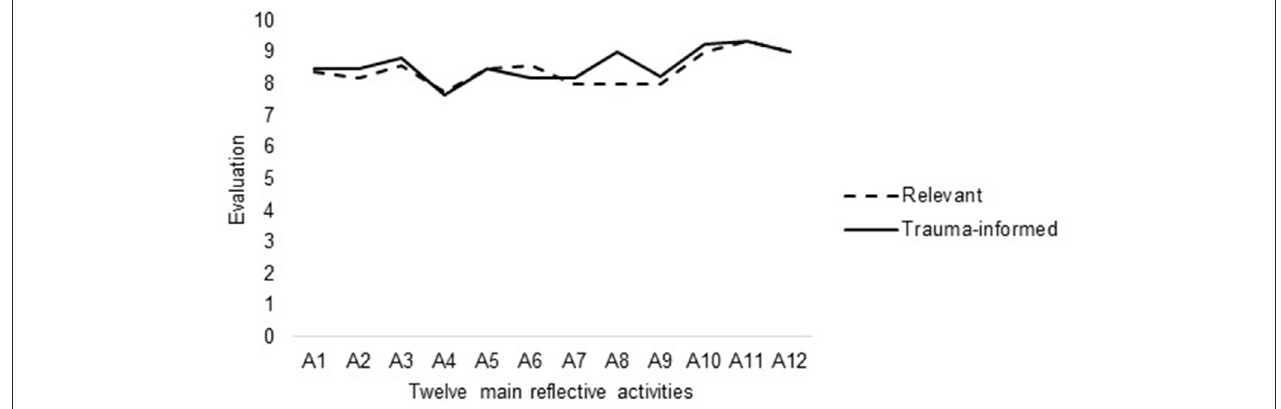
FIGURE 2 | Evaluation of the twelve main reflective activities of the program by a panel of independent experts. Six independent experts rated the twelve main activities of the program using a 10-point Likert scale ranging from 1 (Totally disagree) to 10 (Totally